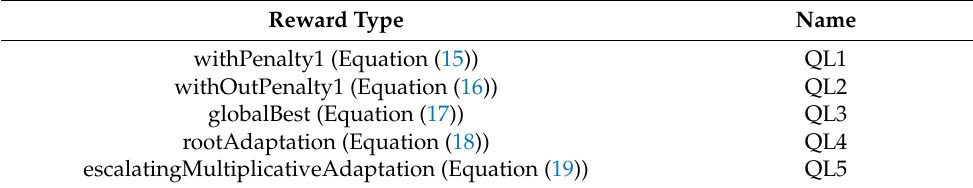
Table 1. Q-Learning Implementation Name.